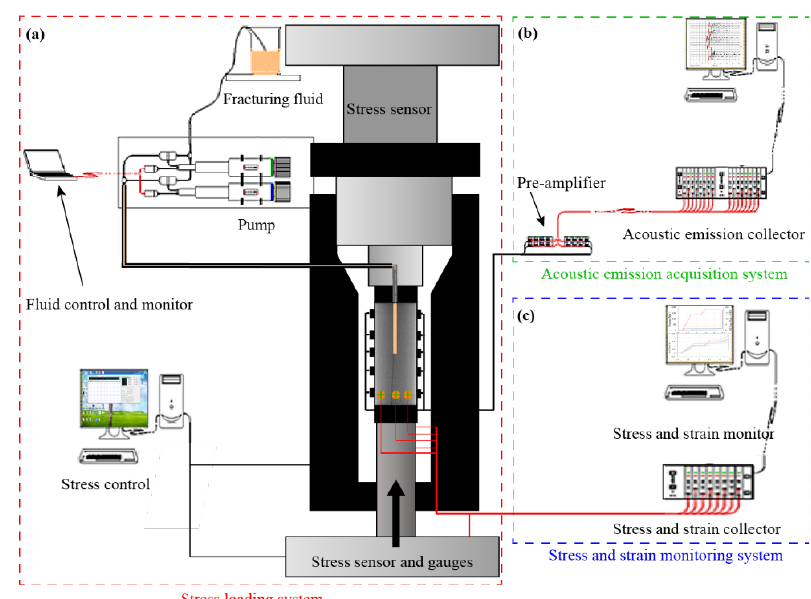
Figure 2. Schematic diagram of the experimental system (citing from [49]).